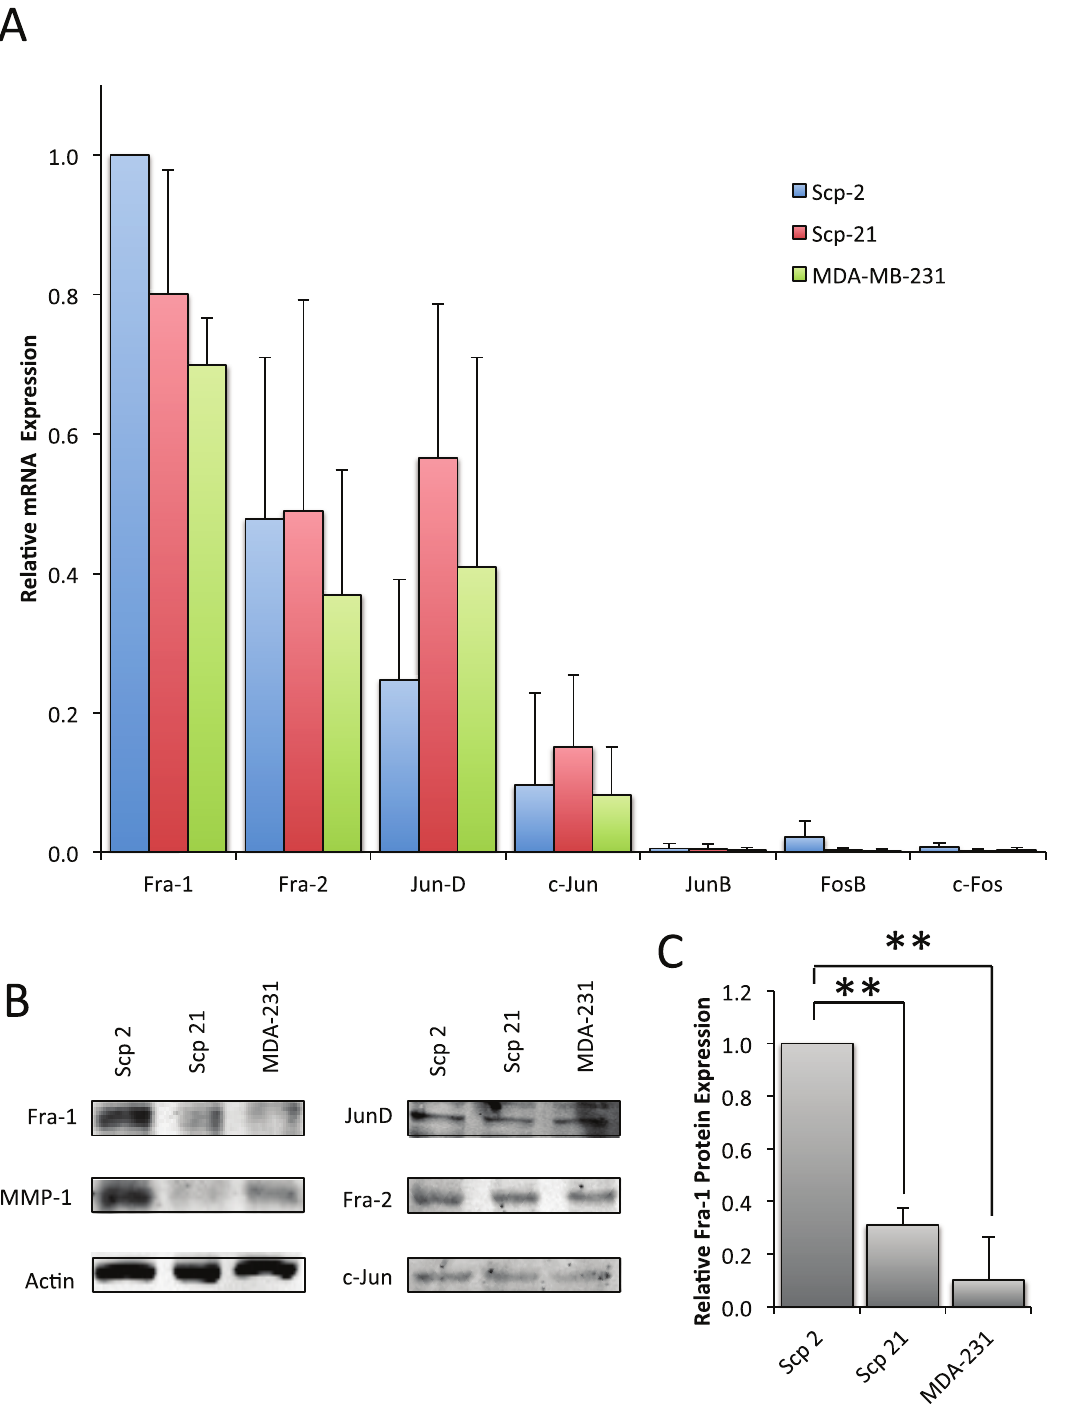
Figure 4. AP-1 family mRNA and protein expression. A ) qPCR of AP-1 family member mRNA expression in Scp-2, Scp-21 and MDA- MB-231 cells. Mean relative values are shown +/- standard deviation from three independent experiments. B ) Immunoblots with anti-AP-1 family antibodies of whole cell lysates from Scp-2, Scp-21, and MDA-MB-231 cells. Anti-MMP-1 is included for comparison and anti-actin antibody served as a loading control. C ) Mean Fra-1 protein band intensity from immunoblots as in ( B ) +/- standard deviation from three independent experiments. **, p < 0.005 for two-tailed